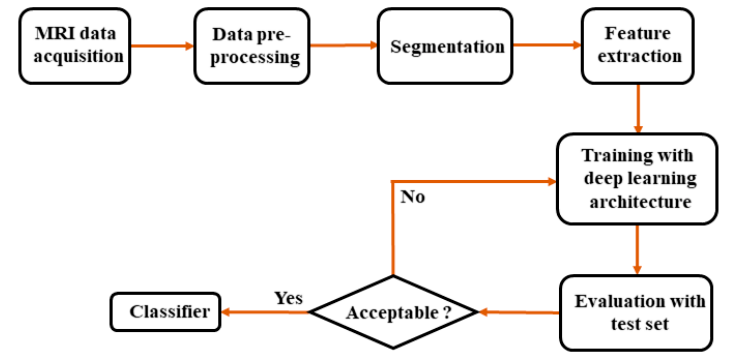
Figure 5. The overall block diagram of AD diagnosis.